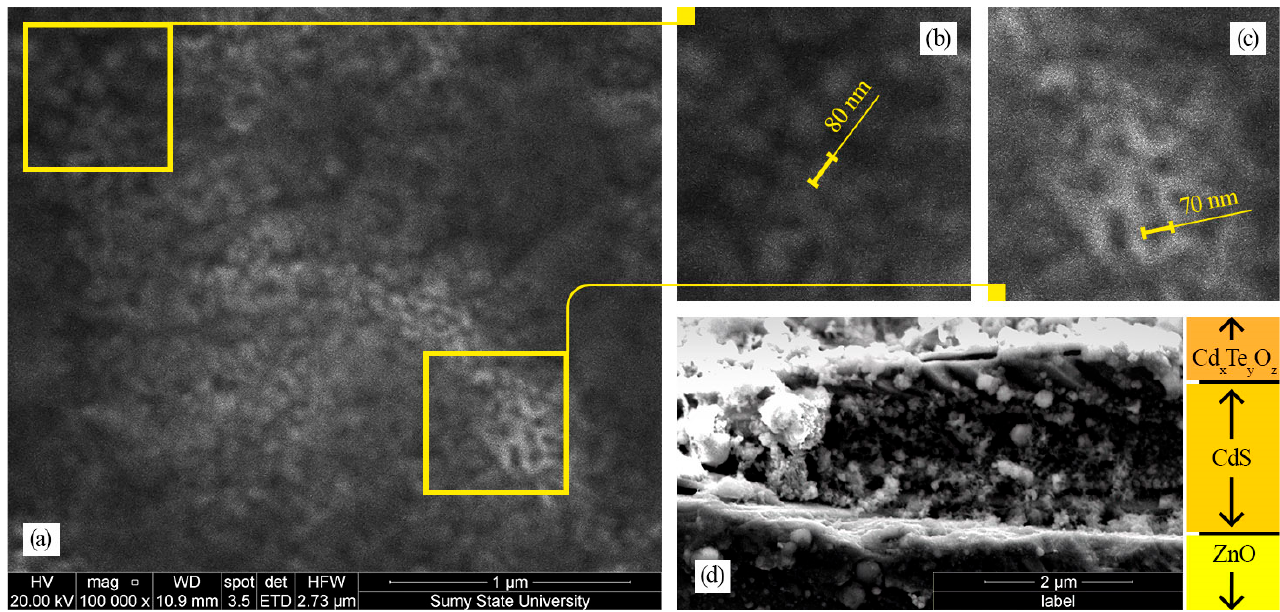
Figure 2. SEM images of the surface ( a – c ) and cross-sectional view ( d ) of the Cd x Te y O z /CdS/ZnO heterostructure.